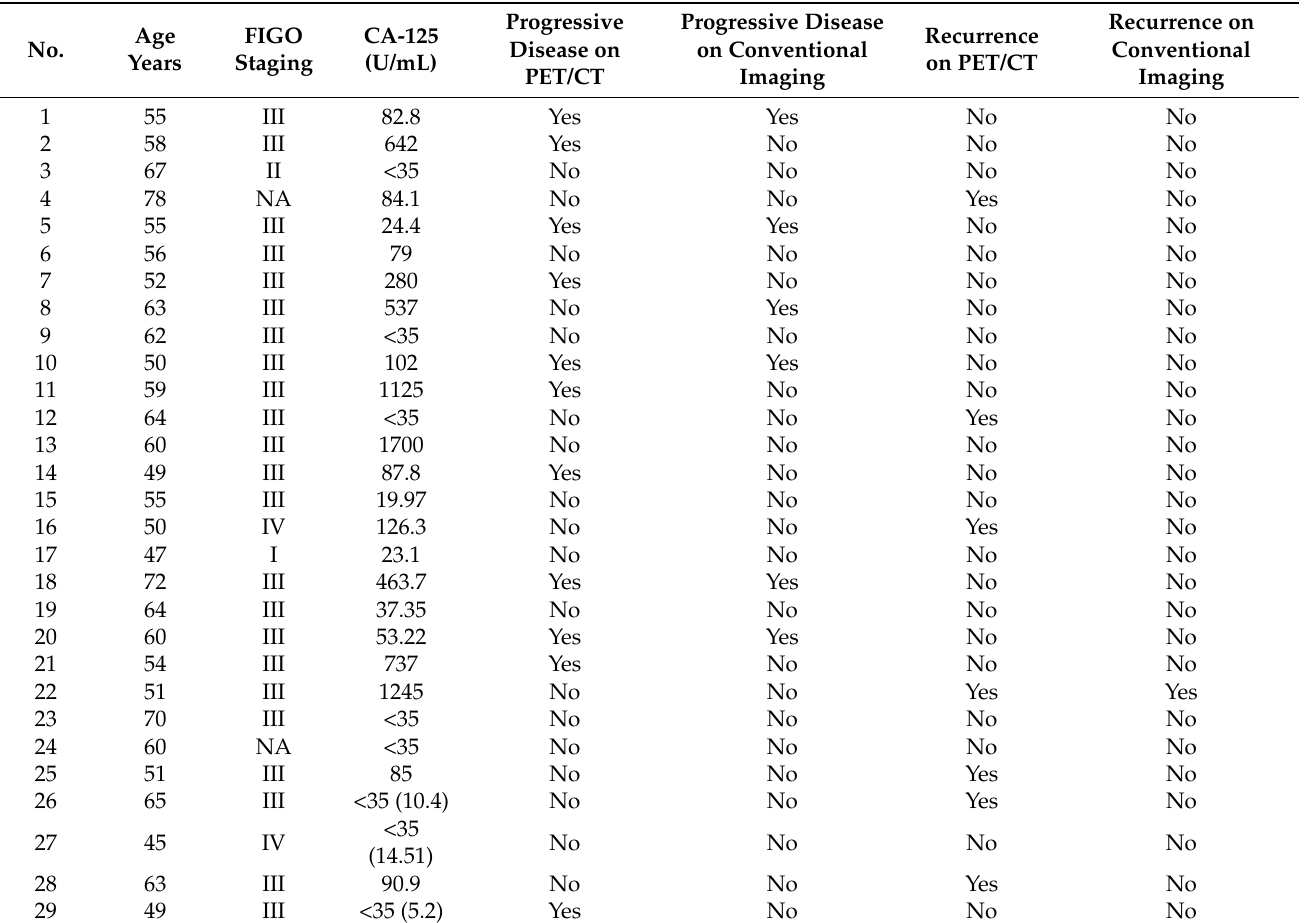
Table 1. The patient group characteristics.